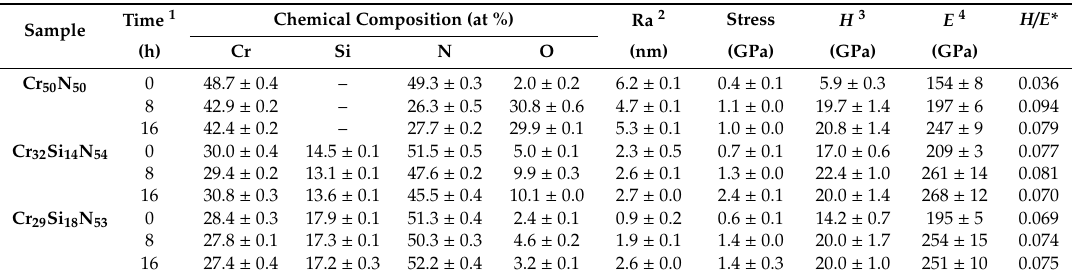
Table 3. Chemical compositions, surface roughness, residual stresses, and mechanical properties of